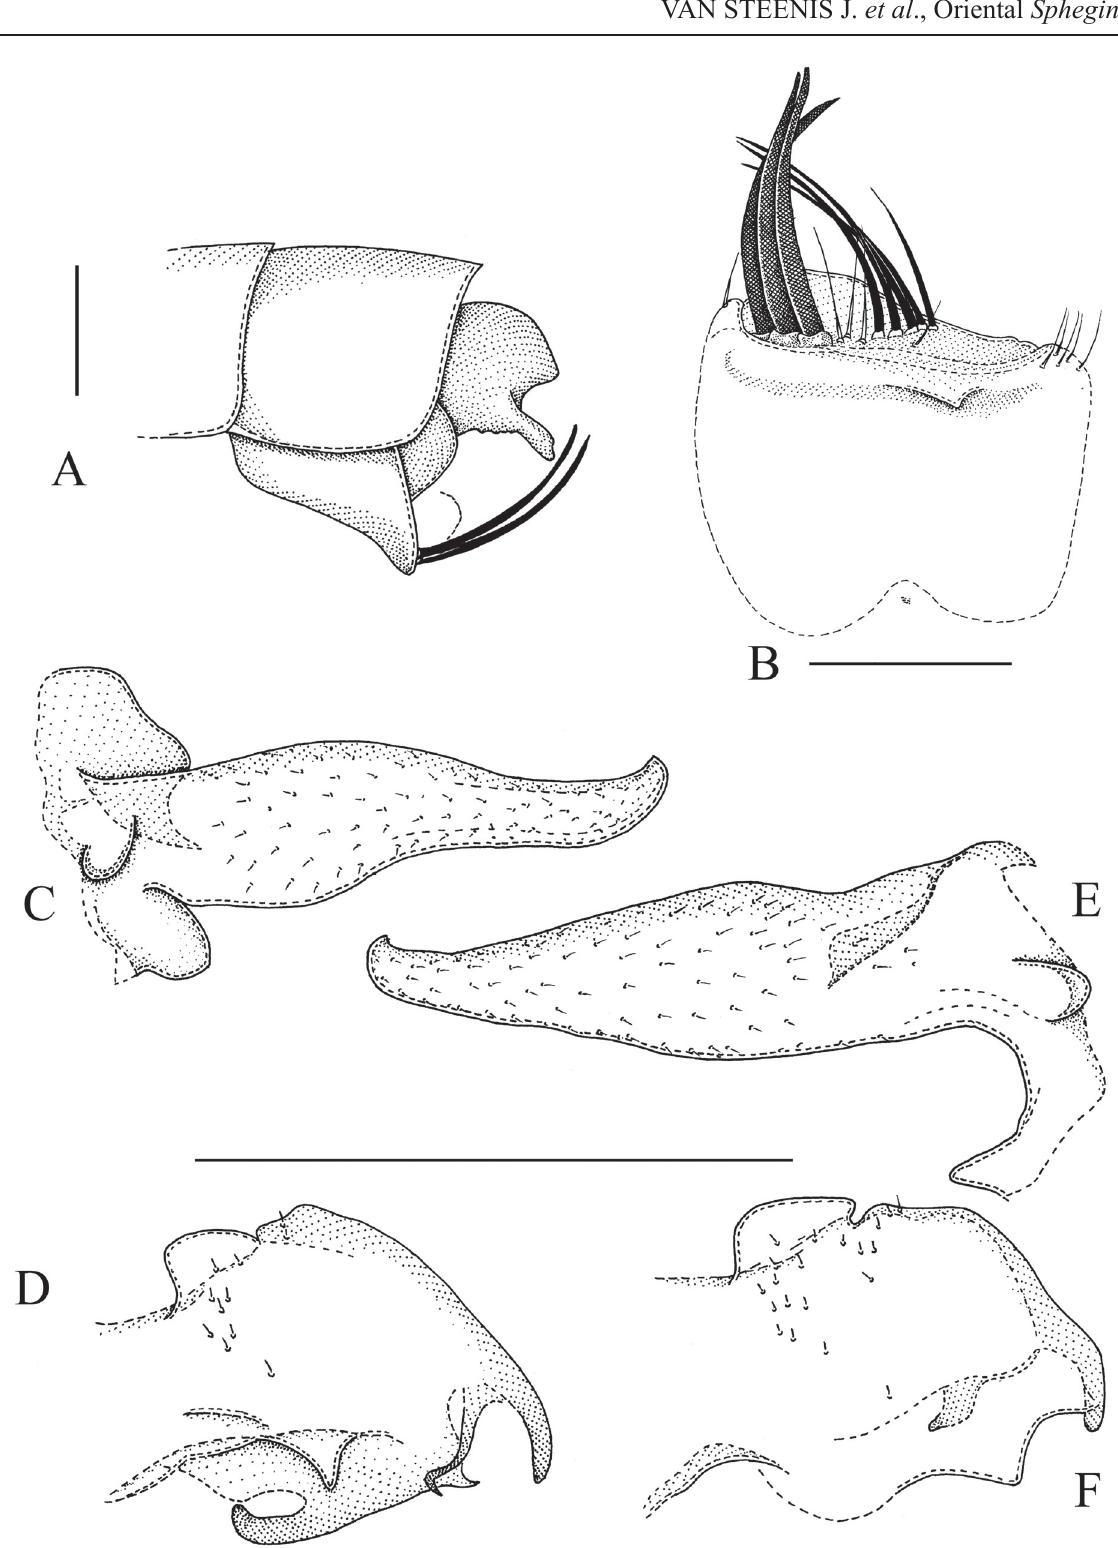
Fig. 42. Sphegina (Asiosphegina) hansoni Thompson, 1966, holotype, ♂ . A . Posterior part of abdomen, left side lateral view. B . Sternum IV, ventral view. C –F . Genitalia. C . Left surstylus, lateral view. D . Right superior lobe, lateral view, focused in microscope from left side. E . Right surstylus, lateral view. F . Left superior lobe, lateral view. Scale bars =